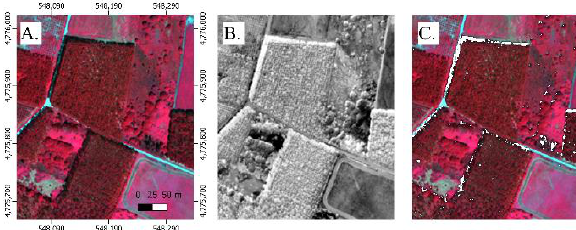
Figure 2. Example of shadow removal. A. Original WorldView image in false color infrared (B8, B5, B3). B. Shadow Detection Index (SDI) (Shahi et al., 2014). C. New raster with shadow data defined as NULL, represented as white pixels.